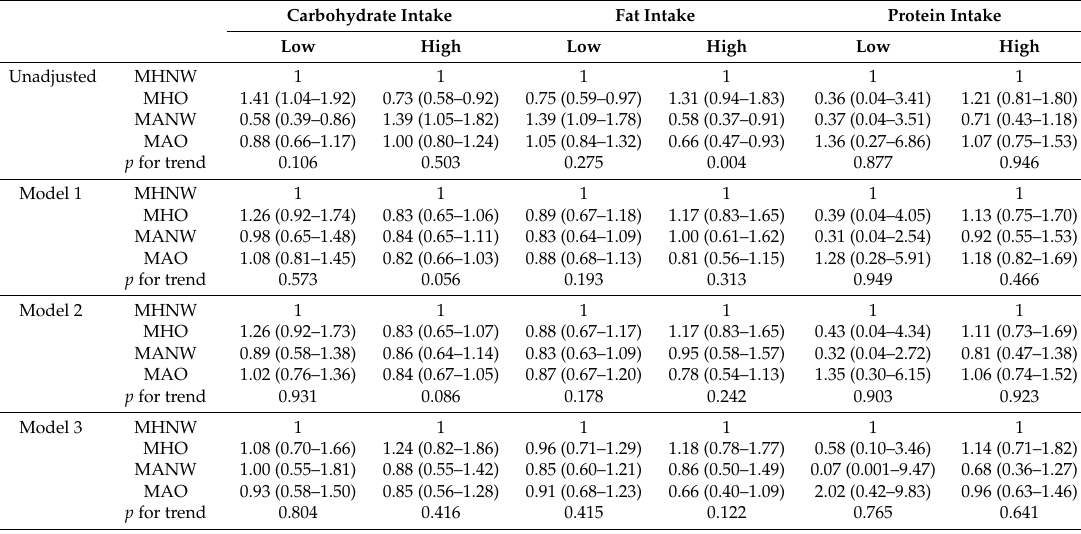
Table 3. Associations between high or low macronutrient intakes and the obesity/metabolic risk phenotypes in